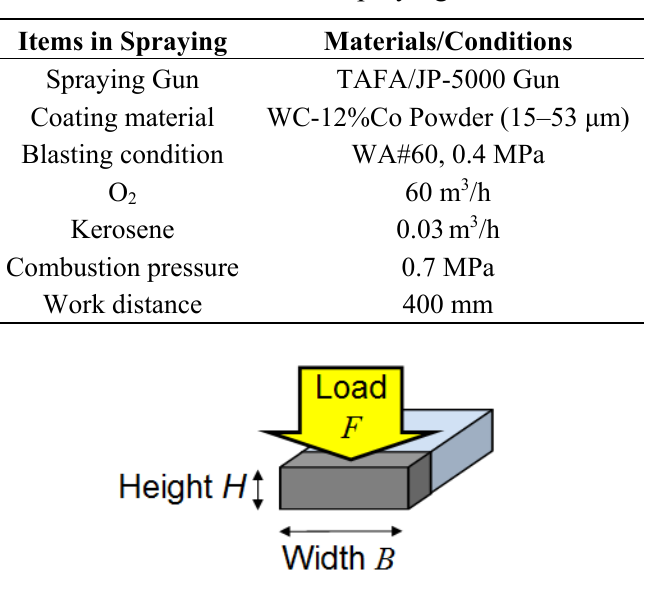
Table 1. HVOF thermal spraying conditions.